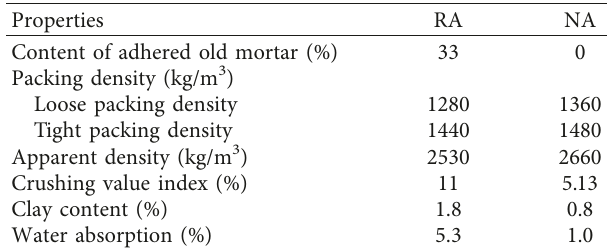
Figure 2: Size distribution of (a) recycled coarse aggregate and (b) recycled powder. (c) SEM images of recycled powder. (d) The comparison on the chemical composition of recycled powder, fly ash, and cement. Table 1: Properties of RA and